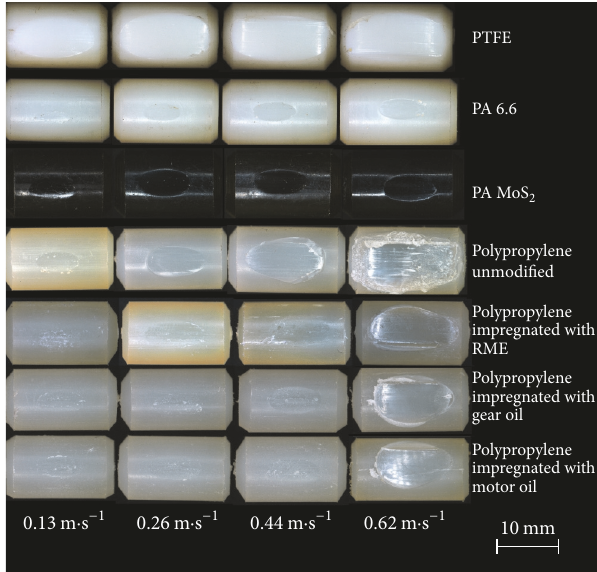
Figure 9: Effect of sliding velocity on worn surfaces of the tested